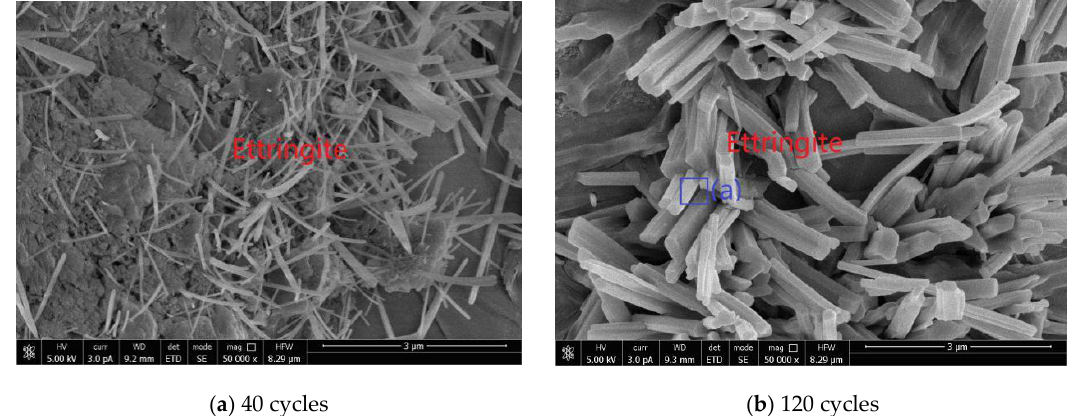
Figure 20. EDS energy spectrum image.